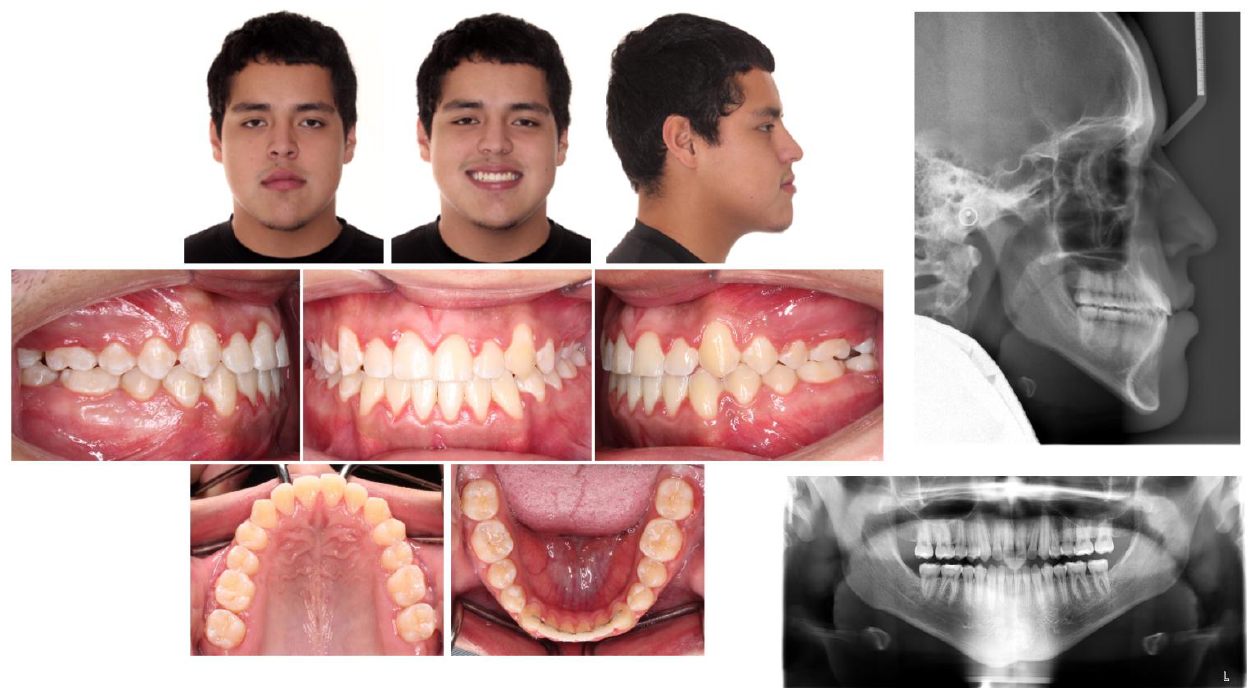
Figure 3. Posttreatment facial and intraoral photographs.